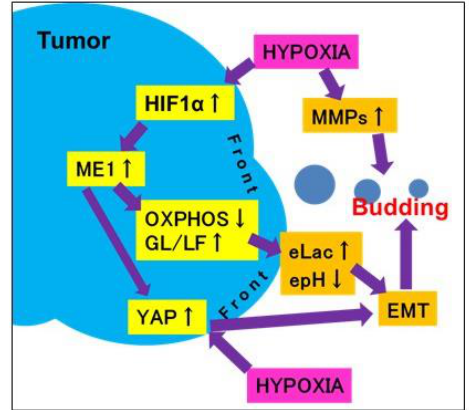
Figure 6. Schema of the mechanism of tumor budding. When cancer cells at the invasive front su ff er hypoxia, they overexpress ME1, which leads to reprogramming of the energy metabolism from oxidative phosphorylation to glycolysis / lactate fermentation. This subsequently increases lactate secretion and decreases the extracellular pH and YAP activation. Due to these alterations, cancer cells at the invasive front undergo budding via an increase in stemness, invasion ability, and EMT phenotype. epH, extracellular pH; eLac, extracellular lactate; OXPHOS, oxidative phosphorylation; MMP, matrix